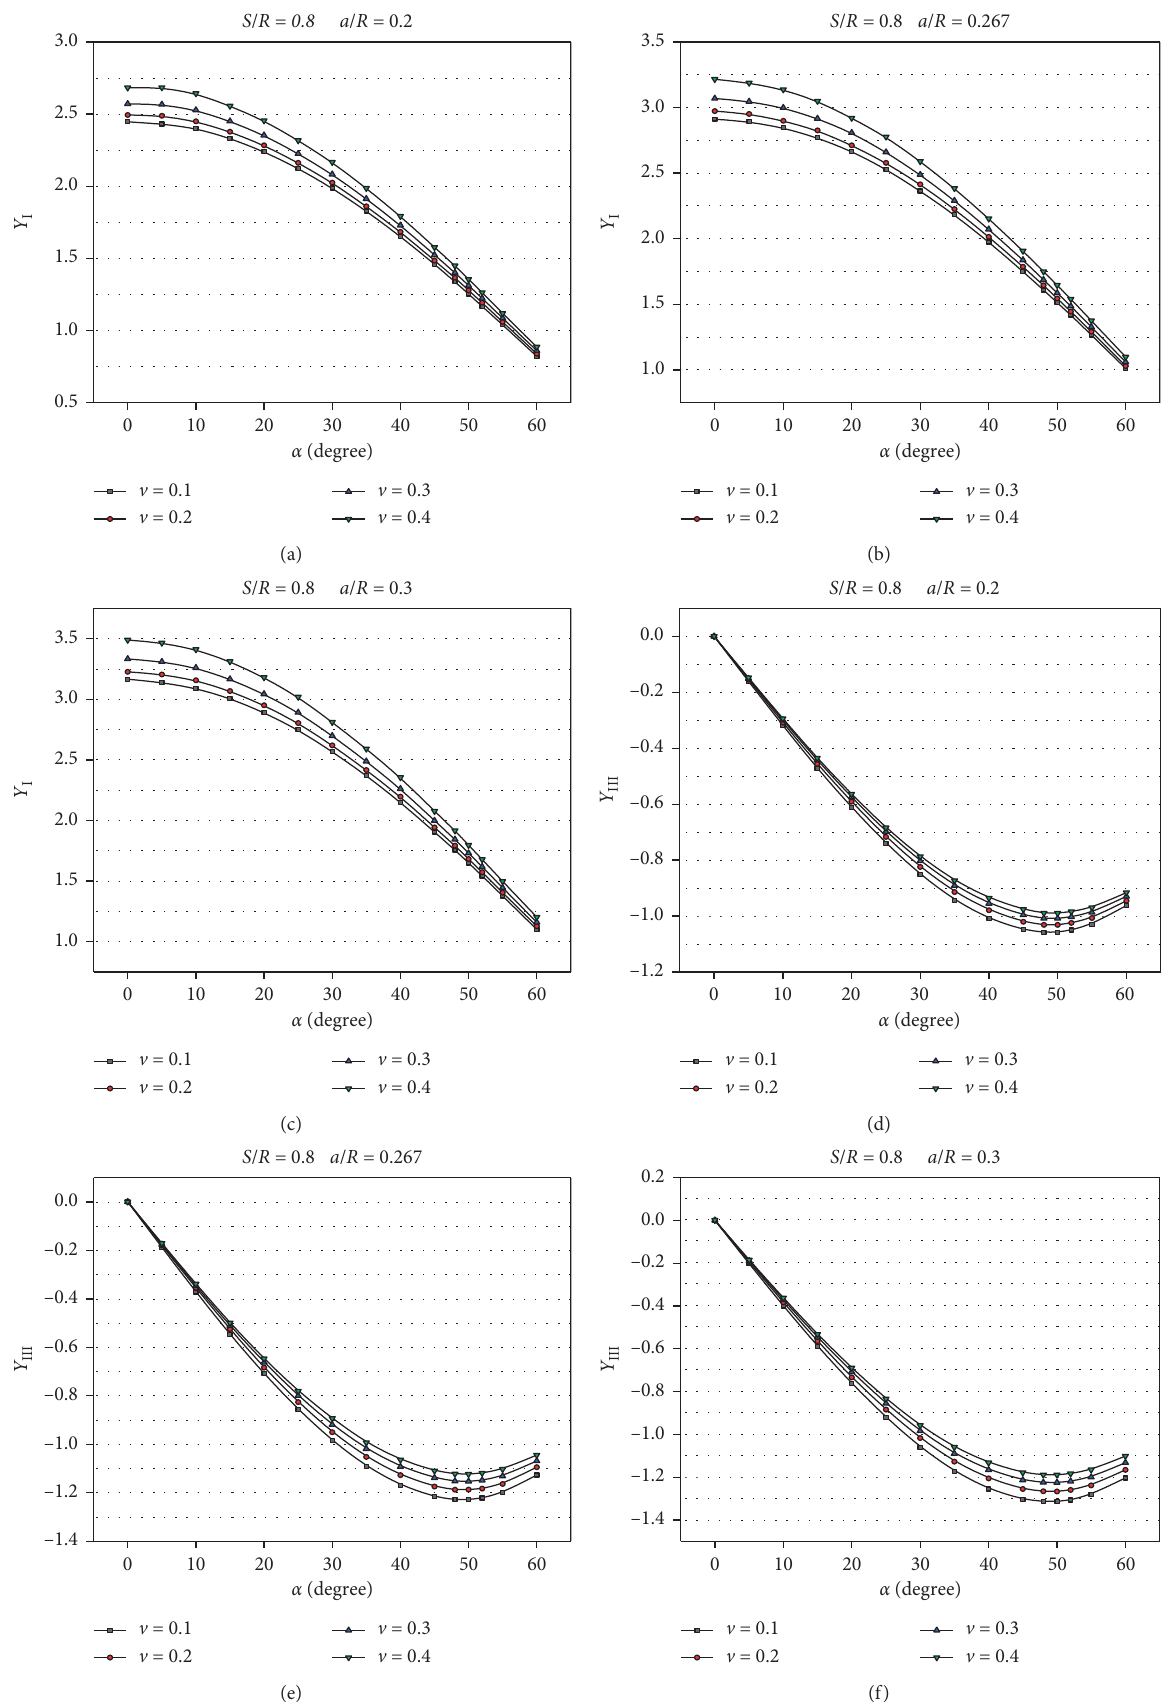
Figure 7: Variations of Y I and Y III with α for different values of a / R and